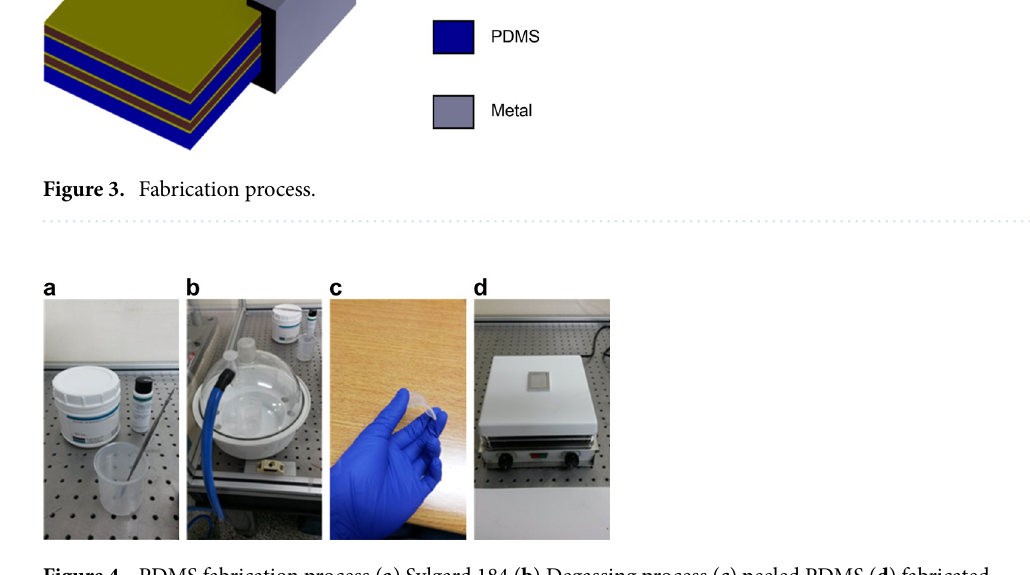
Figure 4. PDMS fabrication process ( a ) Sylgard 184 ( b ) Degassing process ( c ) peeled PDMS ( d ) fabricated